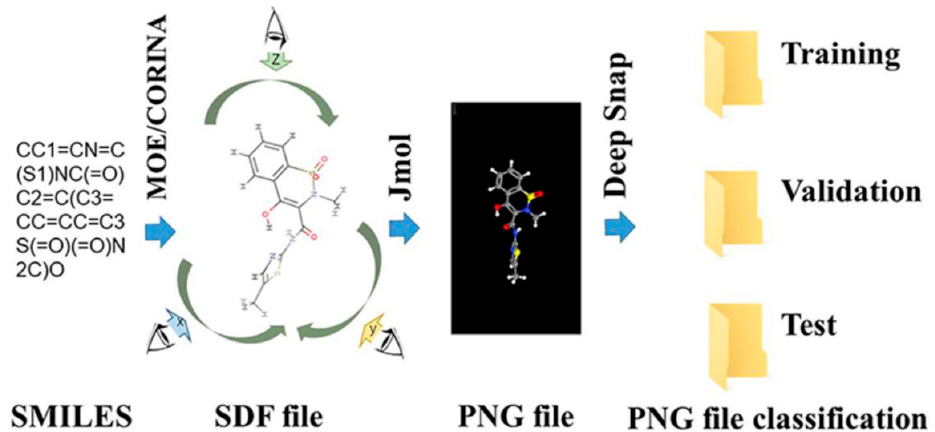
Figure 5. The Deep Snap–Deep Learning procedure. The chemical structure in the SMILES format is converted into a 3D structure in an SDF file. By applying Deep Snap, the 2D chemical-image data are utilized as the input dataset for Deep Learning; the feature values were extracted automatically using a CNN ( Front. Bioeng. Biotechnol. 2019 , 7 , 65. [57]).